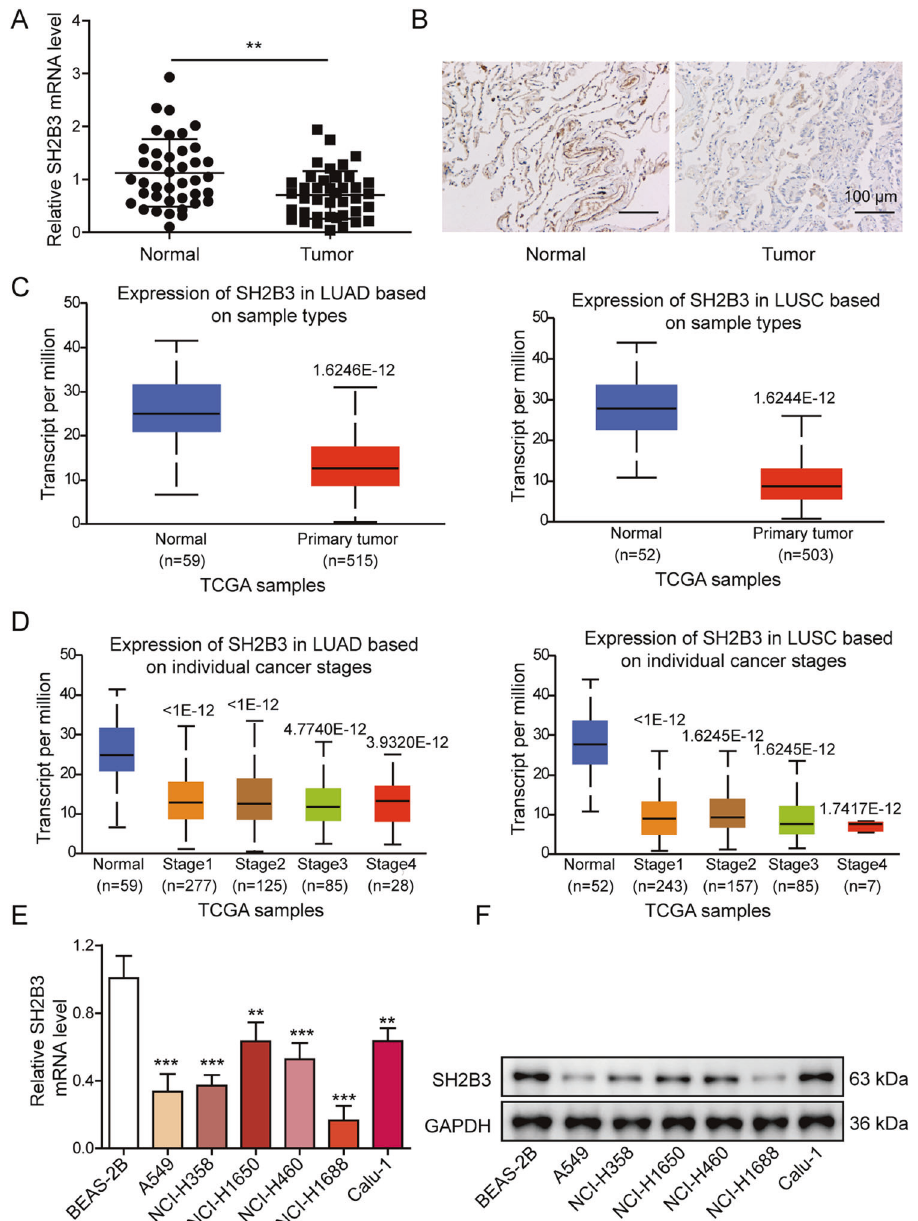
Fig. 1 SH2B3 was diminished in lung cancer tissues and cells. A qRT-PCR analysis of SH2B3 mRNA levels in human lung cancer tissues ( n = 40). B IHC assay to examine SH2B3 protein levels in human lung cancer tissues. C Bioinformatic analysis of SH2B3 mRNA level in human lung cancer tissues from UALCAN database. D Bioinformatic analysis of SH2B3 mRNA level in lung cancer tissues from patients at different stages from UALCAN database. E qRT-PCR analysis of SH2B3 mRNA levels in cultured lung cancer cell lines. F Western blotting to examine SH2B3 protein levels in cultured lung cancer cell lines. *** P < 0.001 and ** P <